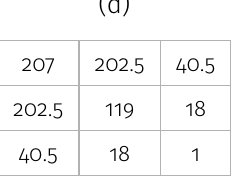
Table IV. (a) Observed counts,